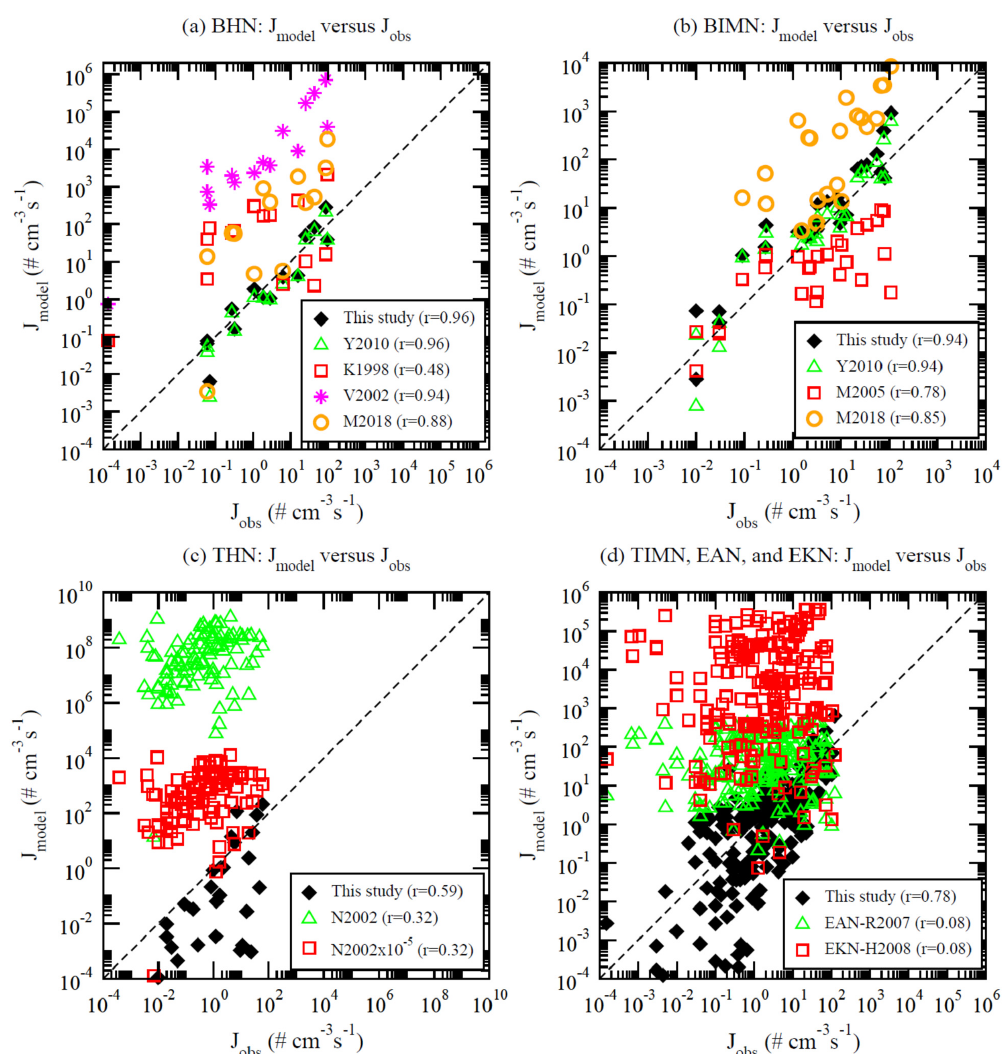
Figure 5. Comparison of nucleation rates based on different models and parameterizations ( J model ) versus corresponding observed values ( J obs ) under (a) BHN, (b) BIMN, (c) THN, and (d) TIMN conditions of CLOUD measurements reported in Table S1 of Dunne et al. (2016). See the text for the references of the models and parameterizations considered here. The correlation coefficient ( r ) between log 10 (J model ) based on each scheme and log 10 (J obs ) is given in the figure legend. The dashed line shows the 1 : 1